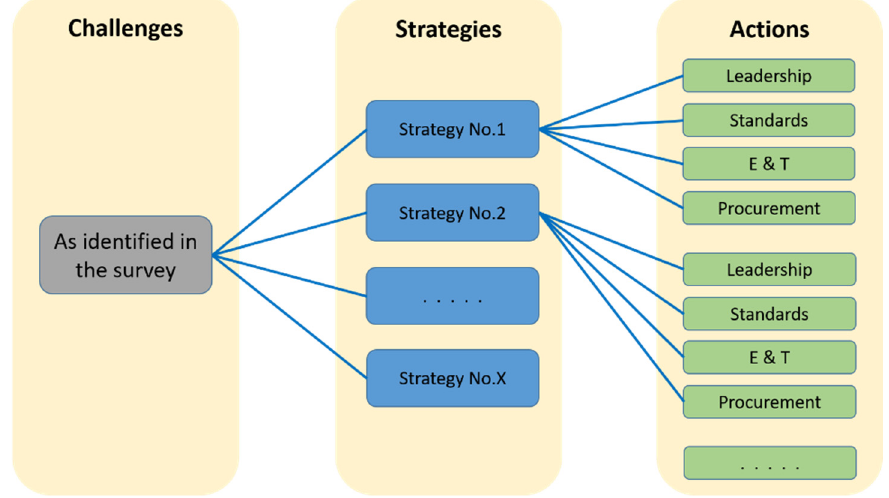
Figure 12. Basic structure and fields of action of the proposed BIM roadmap.